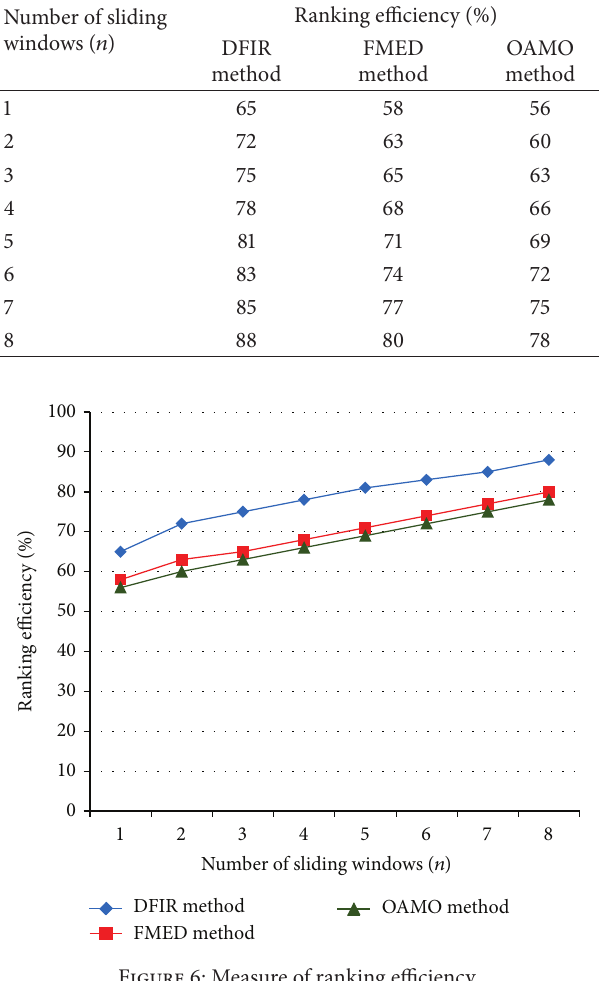
Table 3: Tabulation for ranking efficiency.